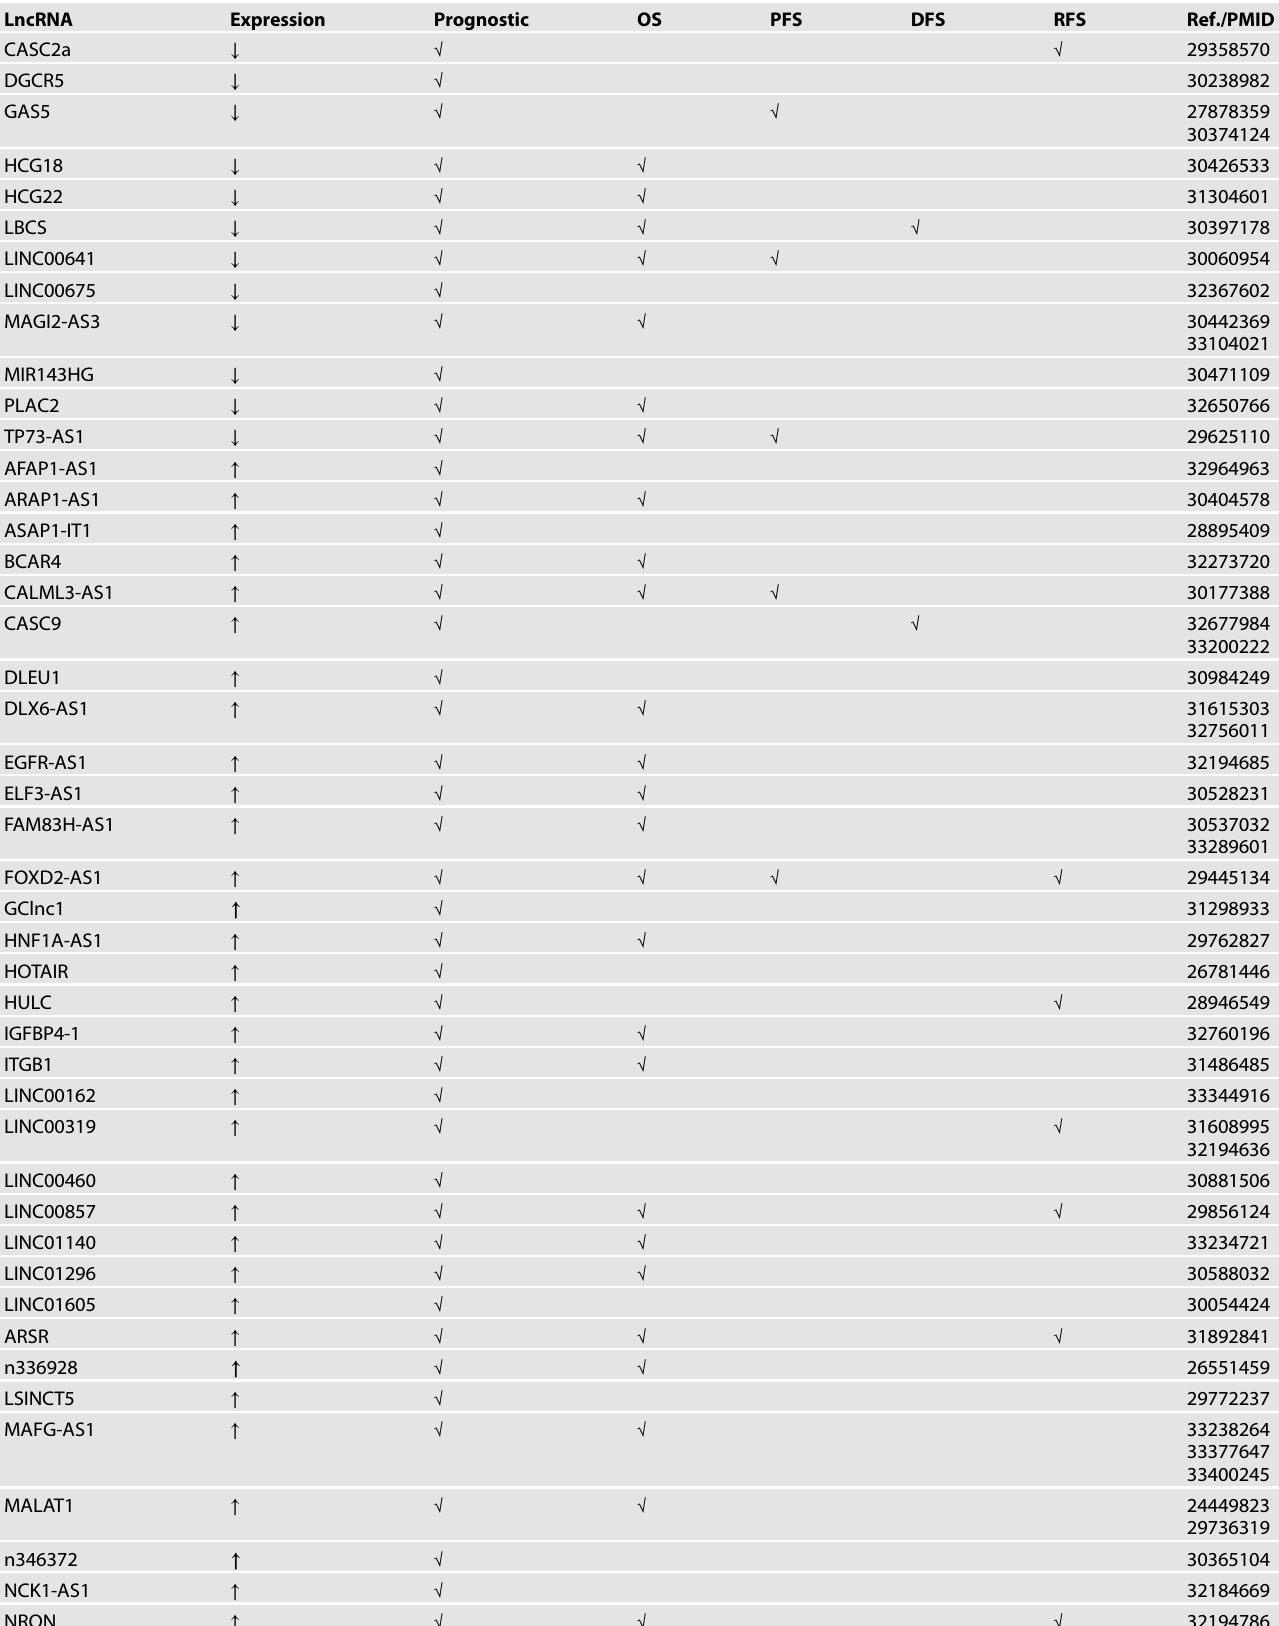
Table 3. The relationship between LncRNA and